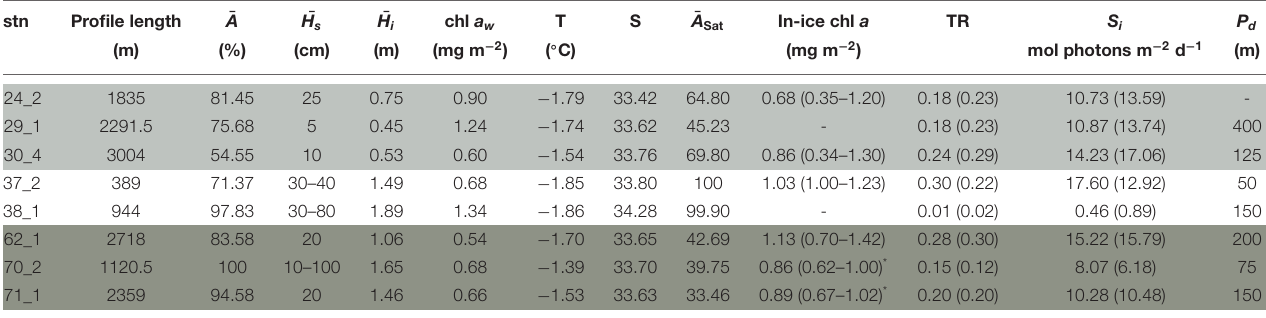
TABLE 7 | Table for PS89 with, for each station (stn), the total profile length, the mean ice concentration ( ¯ A ) along profile, mean snow depth ( ¯ H s ) and mean total ice thickness ( ¯ H i ), under-ice water chl a (chl a w ) multiplied by the vertical section of the SUIT (2m) to obtain integrated values, under-ice water temperature and salinity, ice concentration retrieved from satellite ( ¯ A Sat ), and median in-ice chl a (interquartile range), mean transmittance TR ( ± one standard deviation), mean Insolation S i ( ± one standard deviation), and the draft patch size ( P d ).